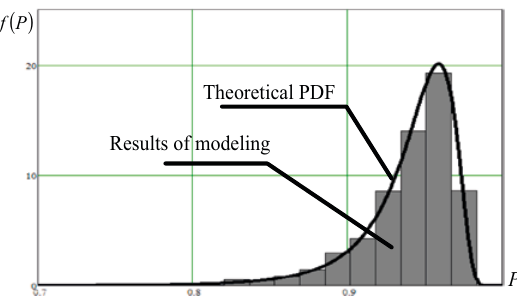
Fig. 2. Theoretical PDF and the results of statistical modeling